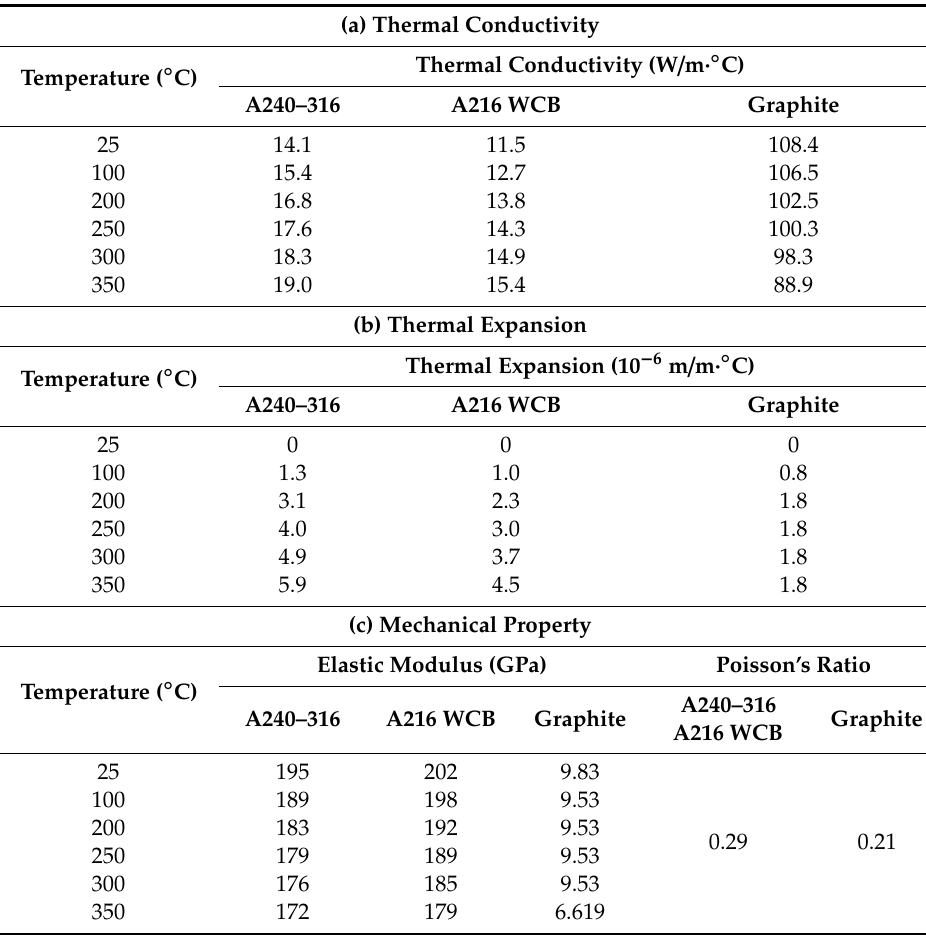
Table 4. Nonlinear material properties according to